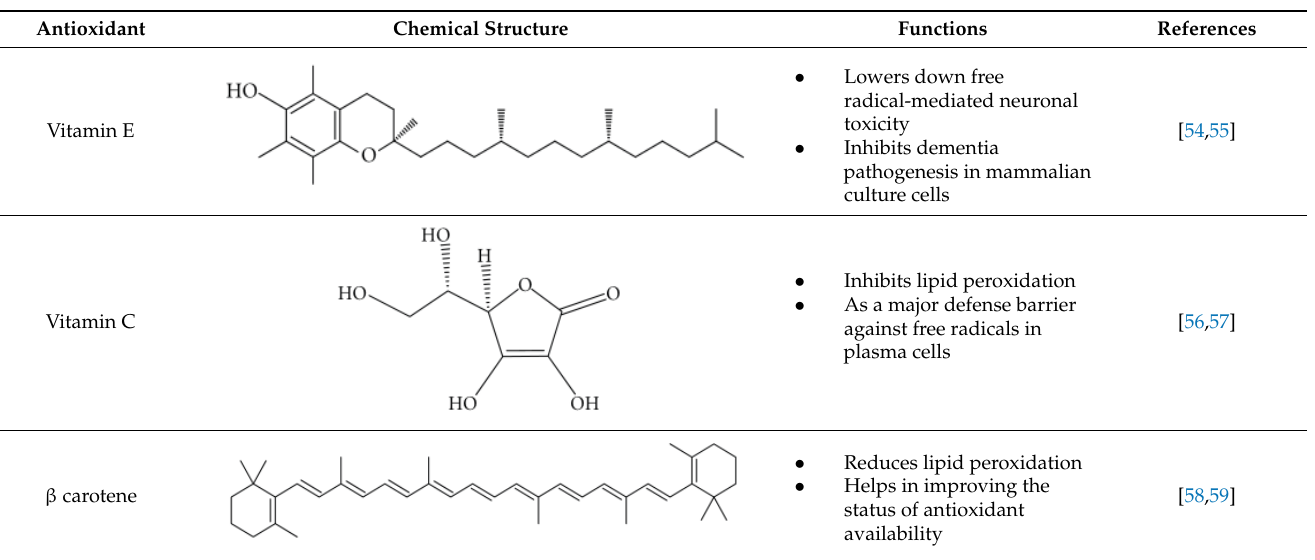
Table 2. List of antioxidants with potential therapeutic effects against AD.